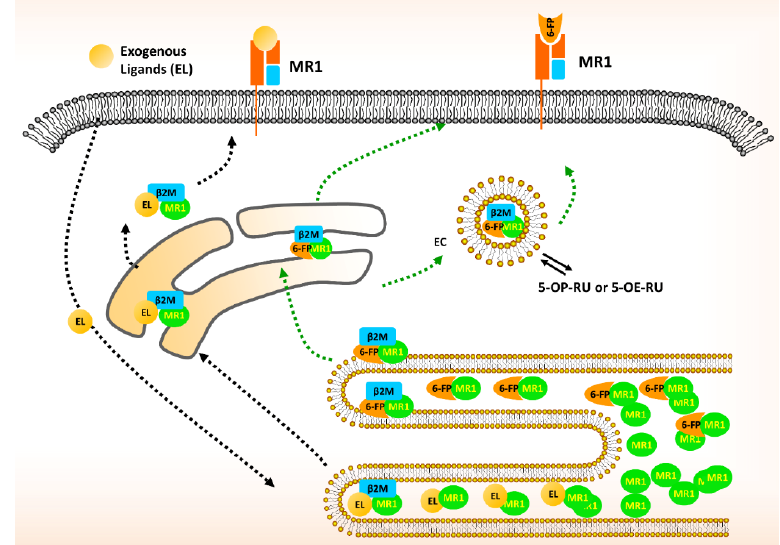
Figure 2. Schematic diagram of MR1 tra ffi cking and presentation. MR1 is synthesized and